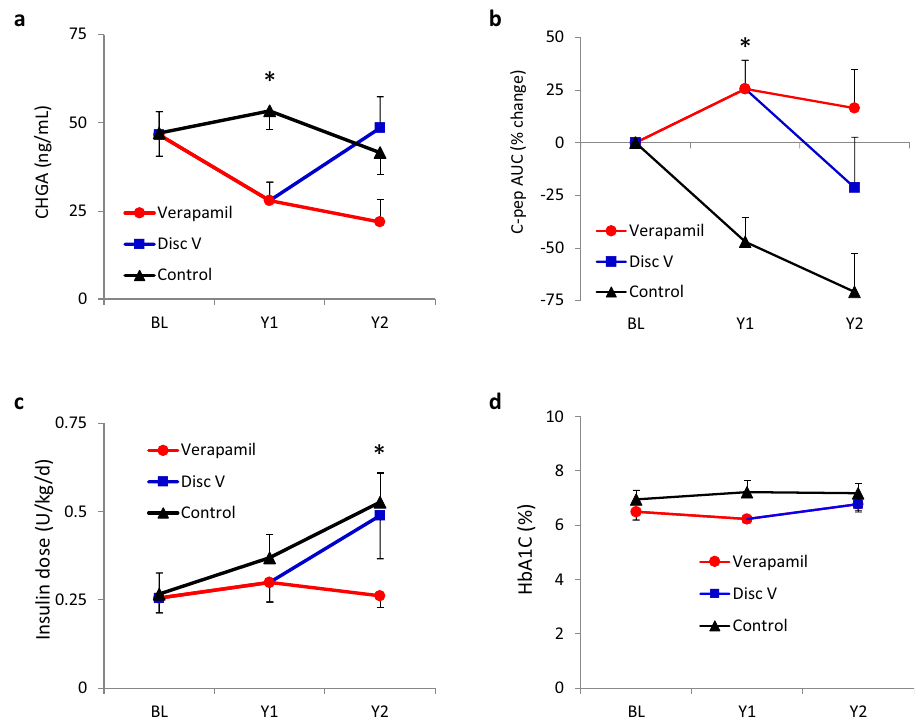
Fig. 2 Insulin requirements, beta cell function, and CHGA over 2 years of T1D treatment with verapamil. Changes over time in serum CHGA as assessed by ELISA ( F 4,19 = 8.723, P = 0.0003) ( a ), C-peptide AUC ( F 4,19 = 4.346, P = 0.012) ( b ), daily insulin dose ( F 4,23 = 3.094, P = 0.036) ( c ) and blood glucose control as assessed by HbA1C ( d ) in subjects with T1D receiving verapamil for 2 years (Verapamil; n = 5), discontinuing verapamil after the fi rst year (Disc V; n = 4), or not taking any verapamil (Control; n = 6). Means ± SEM are shown, two-way repeated-measures ANOVA. Subject characteristics of these subgroups are shown in Supplementary Table 4. Source data are provided as a Source Data fi